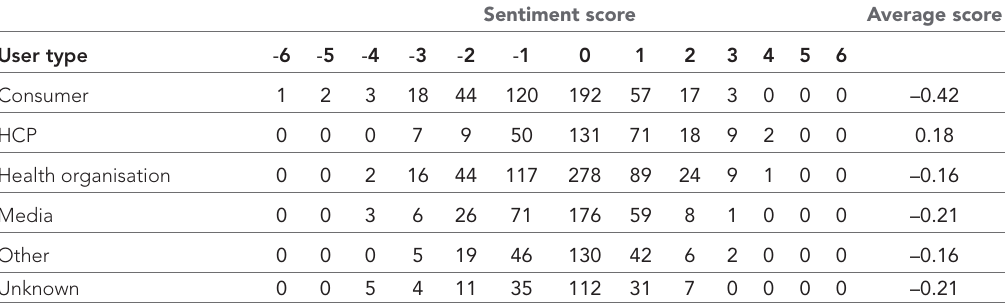
Table 3 Summary of sentiment analysis scores by user type